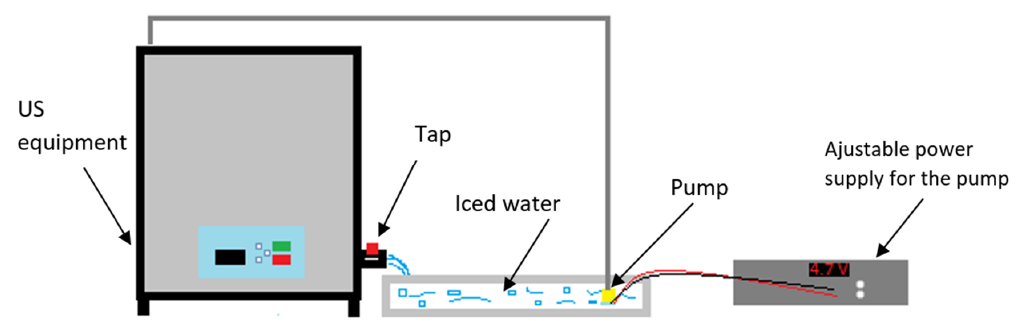
Figure 2. Schematic representation of the ultrasonic equipment with the circulating system.